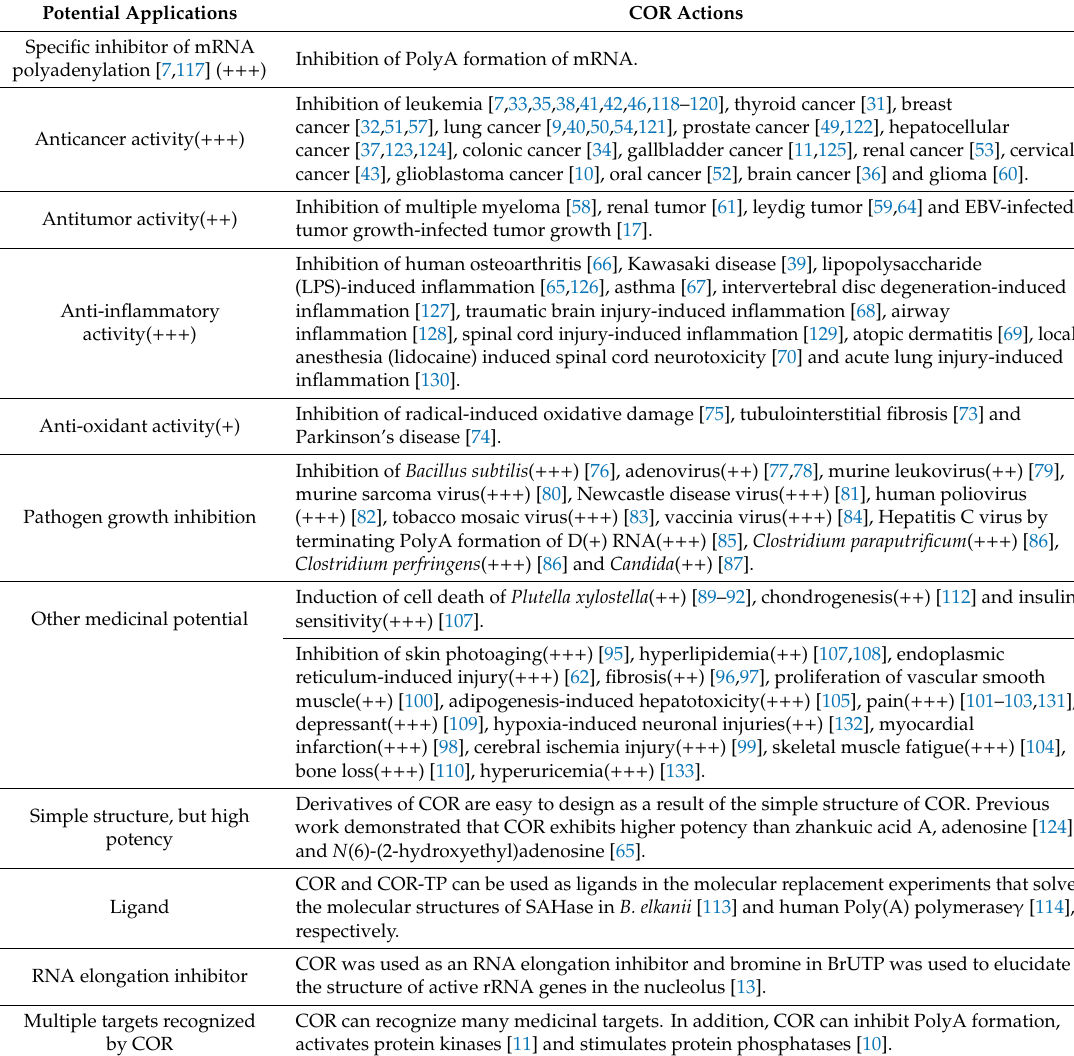
Table 1. Pros of COR in clinical